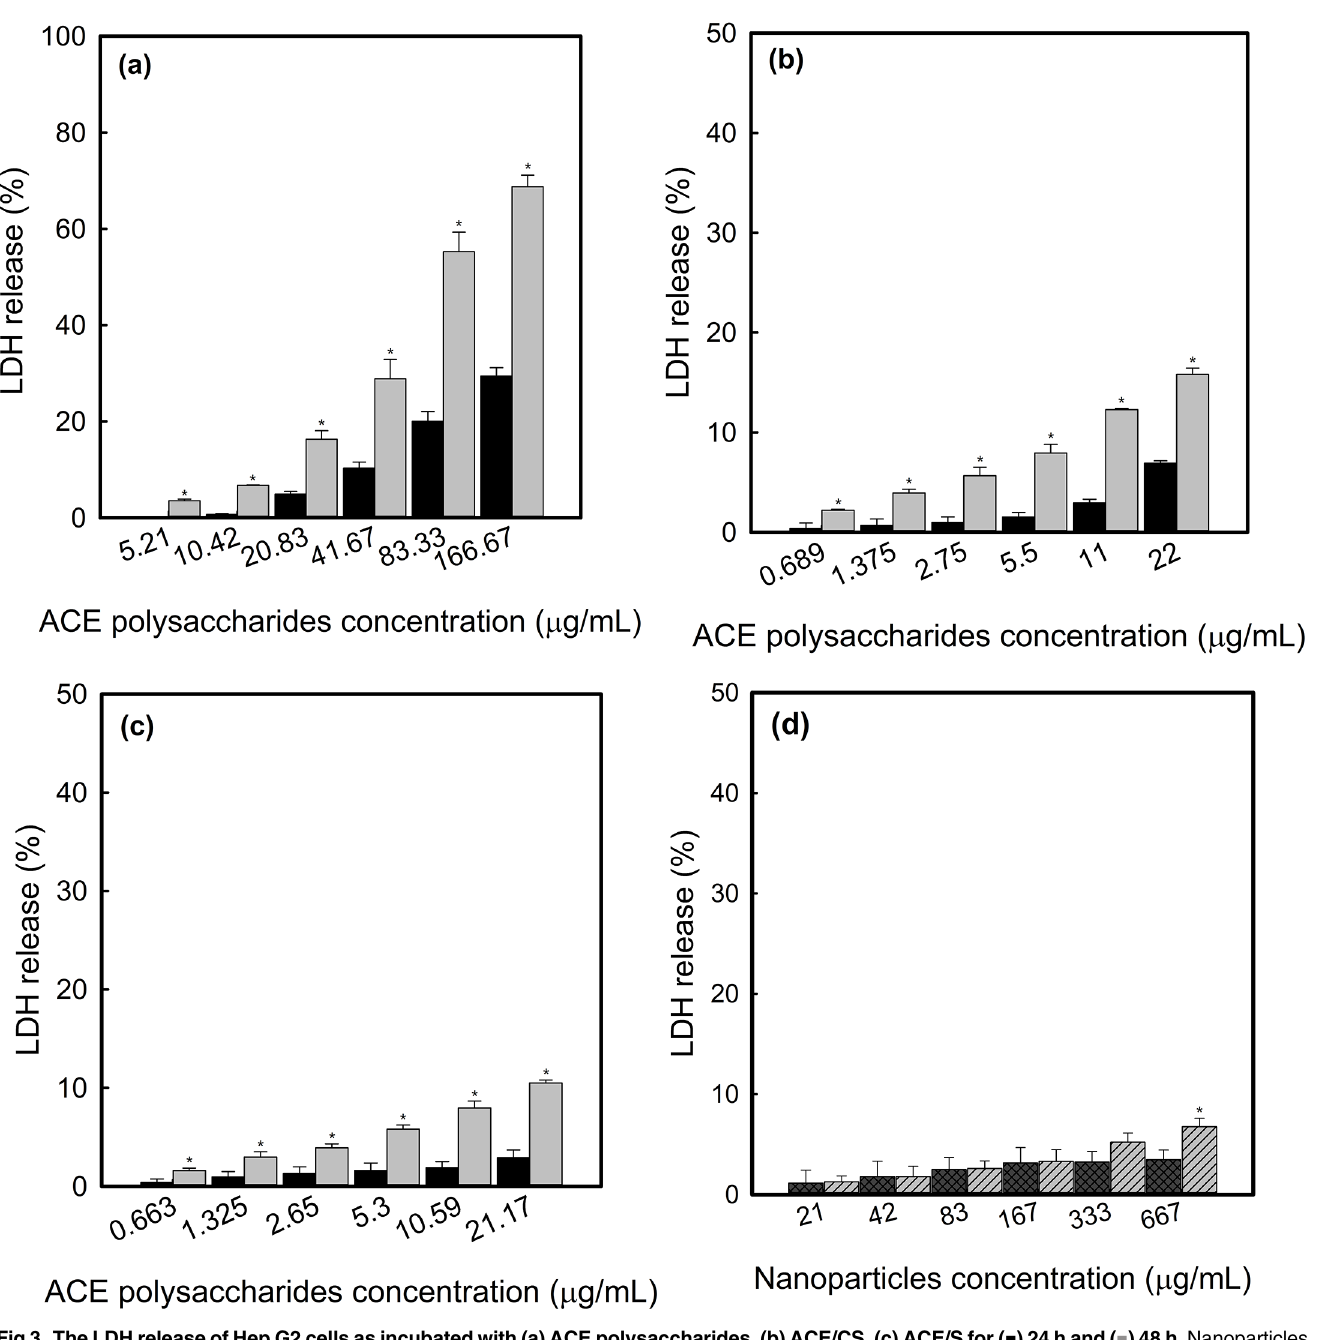
Fig 3. The LDH release of Hep G2 cells as incubated with (a) ACE polysaccharides, (b) ACE/CS, (c) ACE/S for ( ■ ) 24 h and ( ■ ) 48 h. Nanoparticles without ACE polysaccharides, CSNP ( ▩ ) and SNP ( ▨ ) were also examined at 48 h (d). Hep G2 cells were seeded in 96-well plates at a density of 2.0 × 10 5 cells/well. After different treatments and processing, the resulting absorbance was measured at 490 nm and experiments were repeated 3 times independently to ensure reproducibility. Data with standard deviation of the mean are represented as error bars (n = 3) and values with asterisks were signi fi cantly different ( p < 0.05) between 24 h and 48 h in (a-c), CSNP and SNP (d) at the corresponding concentrations. ACE: A . camphorata extract; ACE/ CS: ACE polysaccharides encapsulated by chitosan-silica nanoparticles; ACE/S: ACE polysaccharides encapsulated by silica nanoparticles; CSNP: chitosan-silica nanoparticles; SNP: silica nanoparticles.